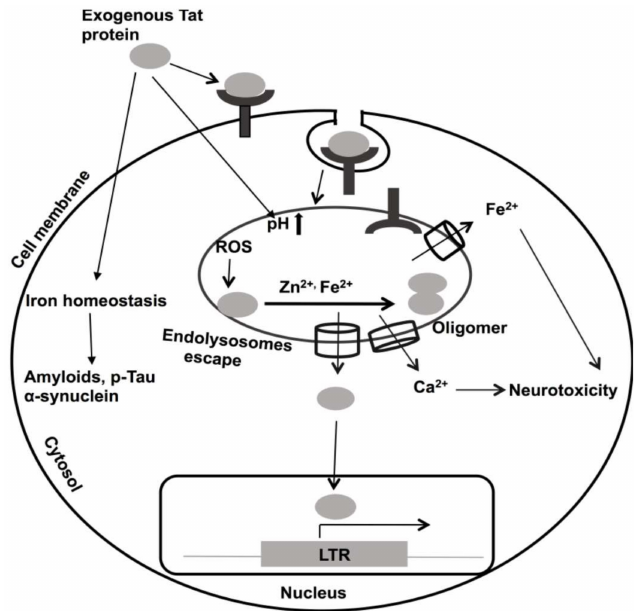
Figure 2. Roles of divalent cations in HIV-1 Tat-mediated pathogenicity. Extracellular Tat is a neurotoxin implicated in the pathogenesis of HIV-1-associated neurocognitive disorders (HAND). Tat enters bystander cells by receptor-mediated endocytosis. Internalized Tat disturbs